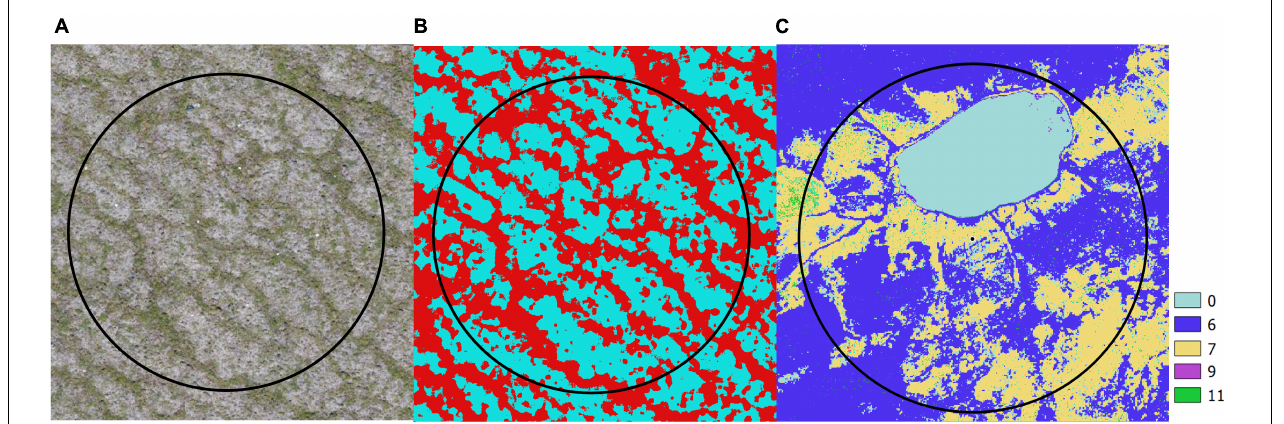
FIGURE 3 | Examples of (A) Red Green Blue true-color orthoimage derived from the RGB drone camera with a 15 m radius circle, (B) classified vegetation map from orthoimage (barren in blue and shrub tundra in red) with a 15 m radius circle, and (C) land-cover map created from Sentinel-2 images with a 3000 m radius circle. The land-cover type IDs are described in Table 3 : 0 – water body, 6 – Closed canopy pine, 7 – Open canopy mixed forest, 9 – Open canopy larch, 11 – Closed canopy spruce.